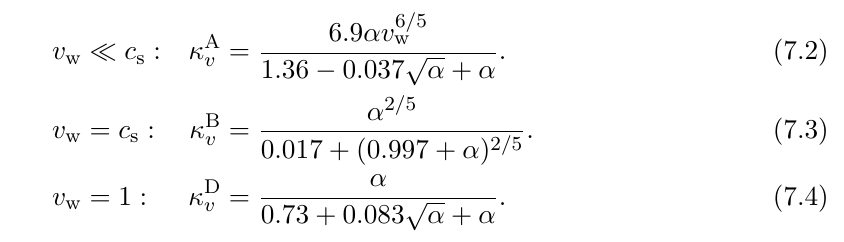
Figure 7 . Parameter points projected in the m χ - h σ ann v i Yukawa couplings. Dashed lines denote the 95% C.L. upper limits on the DM annihilation cross section from the γ -ray observations of dwarf galaxies by Fermi-LAT and MAGIC